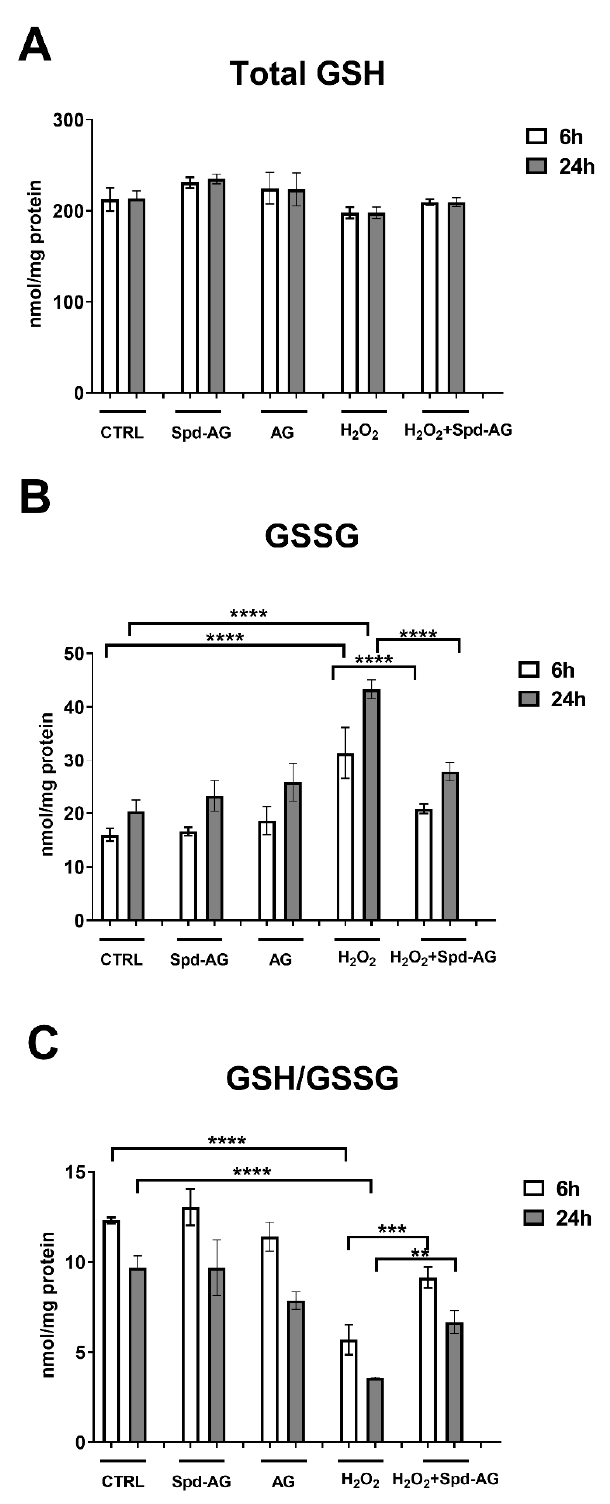
Figure 7. Glutathione homeostasis evaluation. ( A ) Total glutathione (tGSH); ( B ) oxidized glutathione (GSSG) and ( C ) reduced to oxidized glutathione ratio (GSH/GSSG) were evaluated in C2C12 myoblasts after 6 and 24 h in the presence of aminoguanidine (AG, 1 mM), spermidine (Spd, 10 µ M), hydrogen peroxide (H 2 O 2 , 0.3 mM) and combined treatments. Data presented are the mean ± SEM of three experiments, each performed in triplicate. A two-way ANOVA test followed by Bonferroni’s multiple comparison test was performed. ** p < 0.01; *** p < 0.001; **** p <